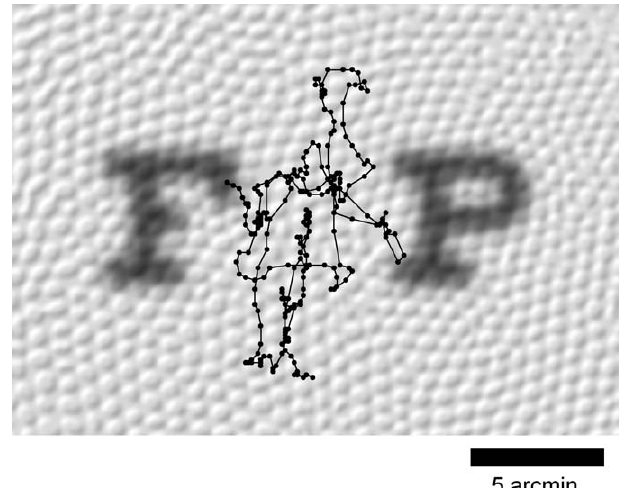
Figure 1. The Neighboring Letters ‘‘ F ’’ and ‘‘ P ’’ on the 20/20 Line of the Snellen Eye Chart, Blurred by a Gaussian of Diameter 0.5 arcmin and Projected onto an Image of the Foveal Cone Mosaic (Photoreceptor Image Modified from [92]) The 1-arcmin features that distinguish the letters extend over only a few photoreceptors. Also shown is a sample fixational eye movement trajectory for a standing subject (courtesy of [25]), sampled every 2 ms for a duration of 500 ms and then smoothed with a 4-ms boxcar filter.